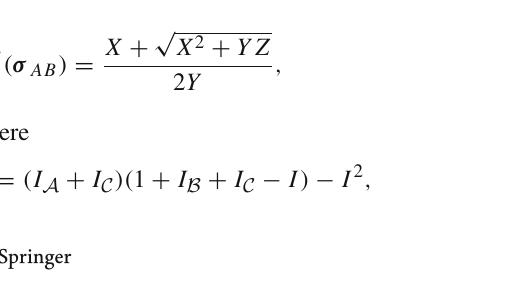
For the bipartite state ρ AB , its covariance matrix (second moments) has the form